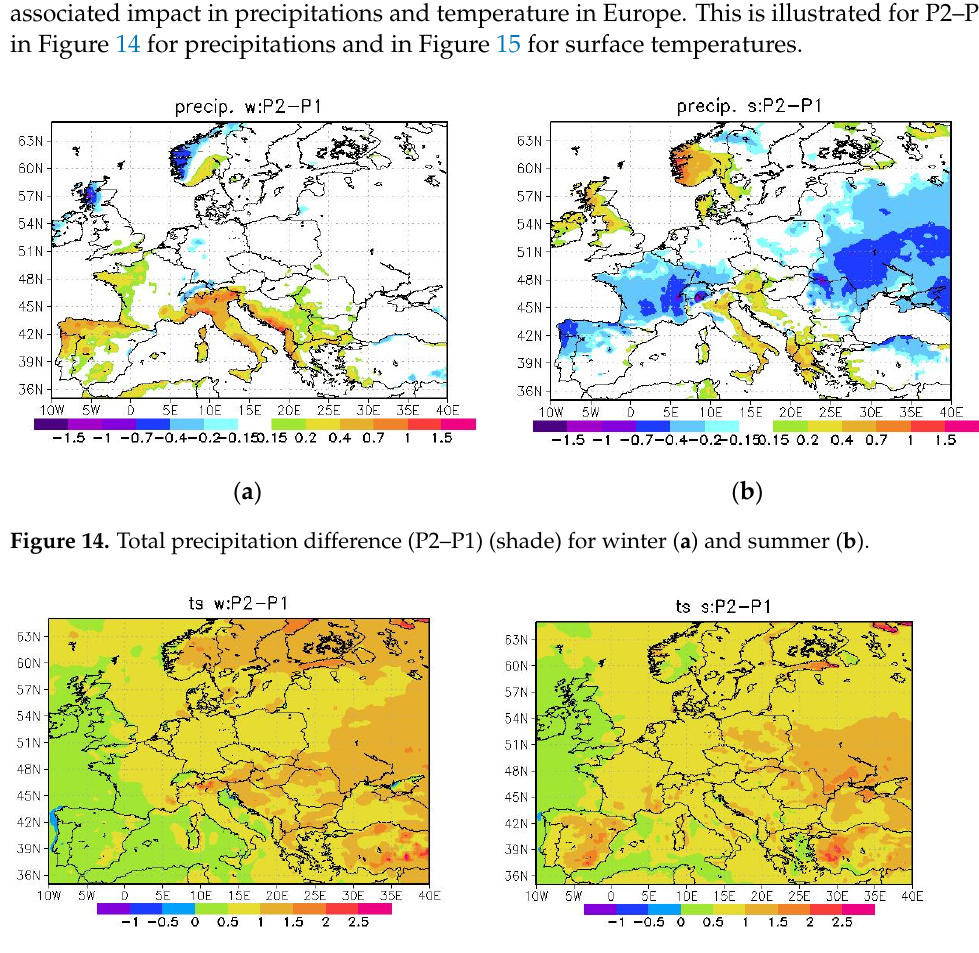
Figure 15. Surface temperature (10 cm of soil) difference (P2–P1) (shade) for winter ( a ) and summer ( b ).